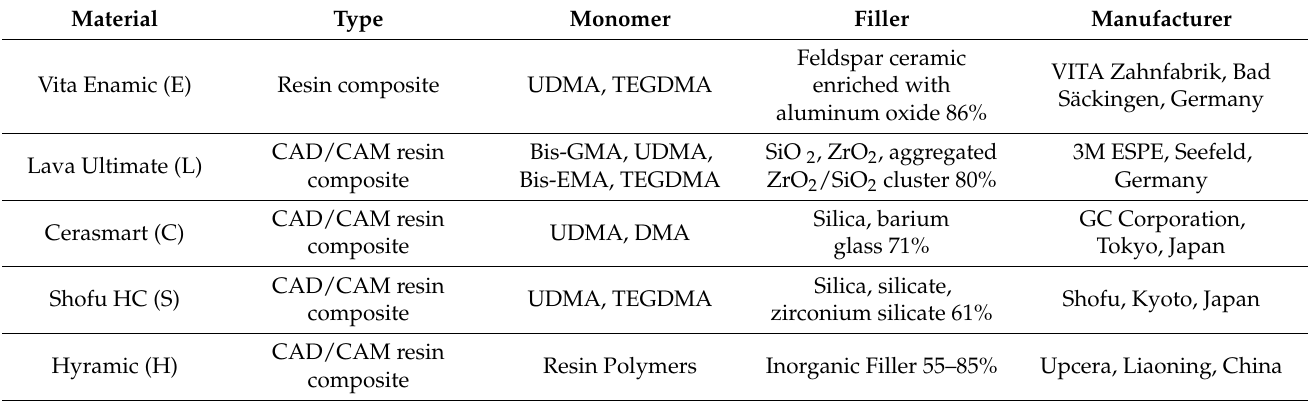
Table 1. Composition and manufacturer specifications of tested materials